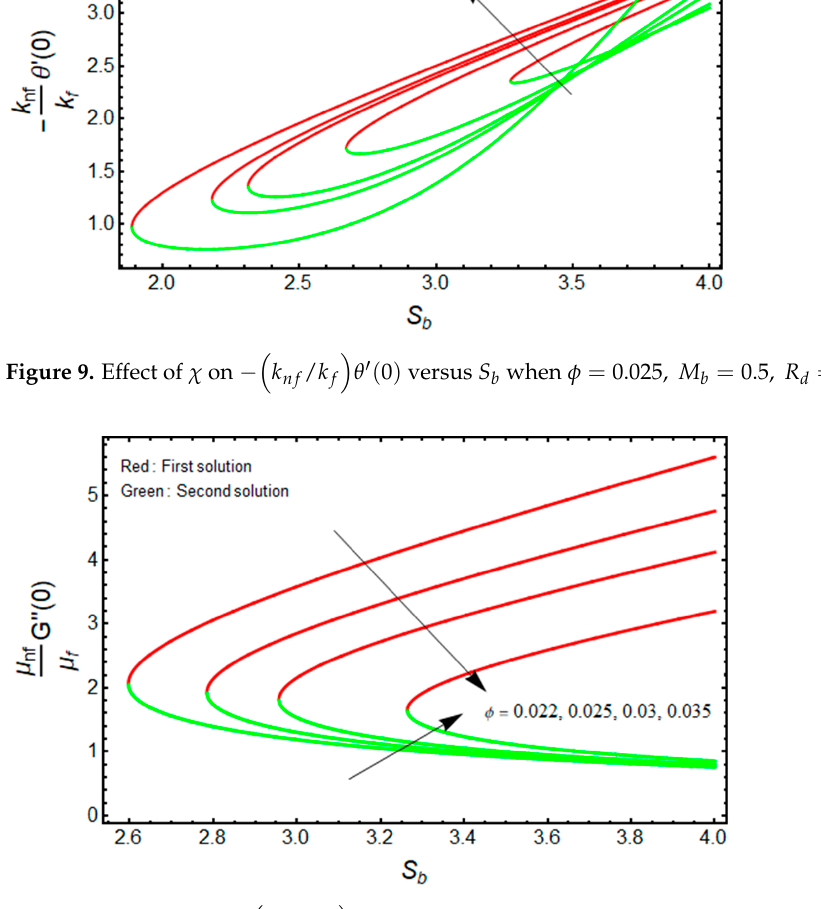
Figure 10. Effect of χ on